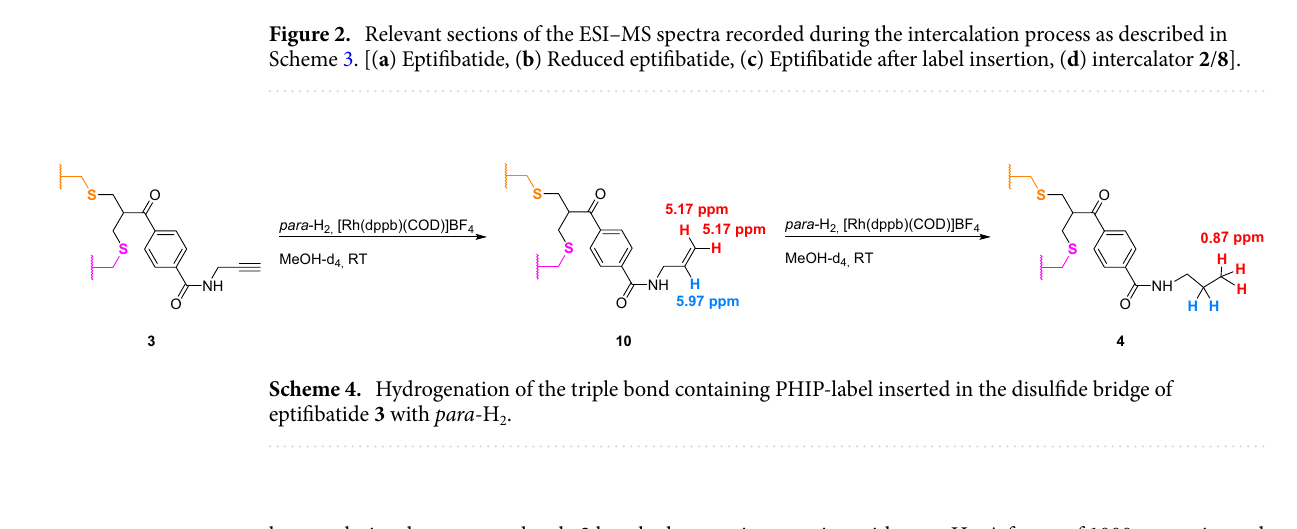
hyperpolarize the target molecule 3 by a hydrogenation reaction with para -H 2 . A factor of 1000 was estimated as a lower limit for the signal enhancement of the hyperpolarized protons of the newly formed vinyl group in comparison with the final formed alkyl group. This result paves the way for future applications of ethynyl-sub- stituted systems like 2 / 8 to be successfully used for future PHIP-applications, utilizing the site selective opening of disulfide bridges in biologically active compounds.